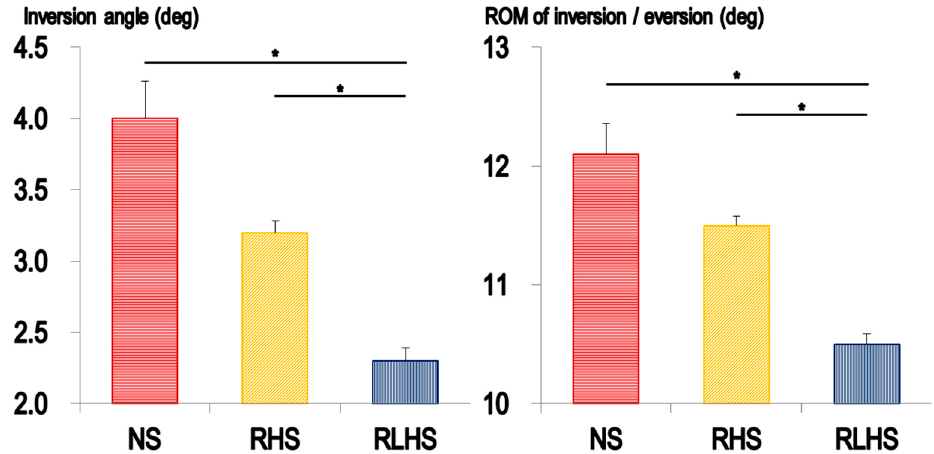
Figure 4. Inversion at toe off (left) and ROM of inversion–eversion during the stance phase of running (right). * indicates a significant difference between the shoes at α = 0.05.